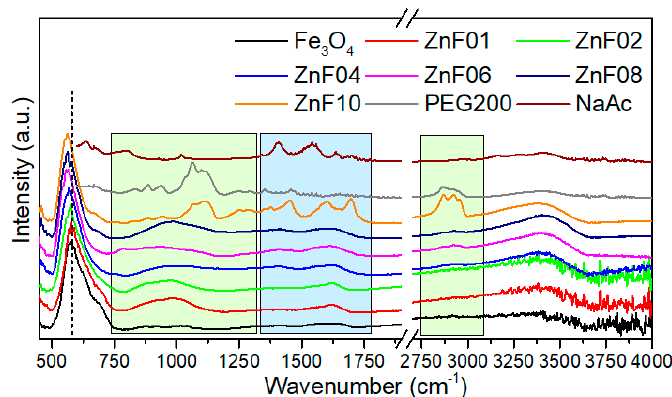
Figure 3. FT-IR spectra of Fe 3 O 4 , ZnF particles, PEG200, and sodium acetate. The spectra are normalized to the highest absorption band and shifted for clarity. The dashed line indicates the shift of the stretching mode of the Fe-O bond. The green and blue rectangles delimit the area of vibrational bands of PEG and acetate, respectively.